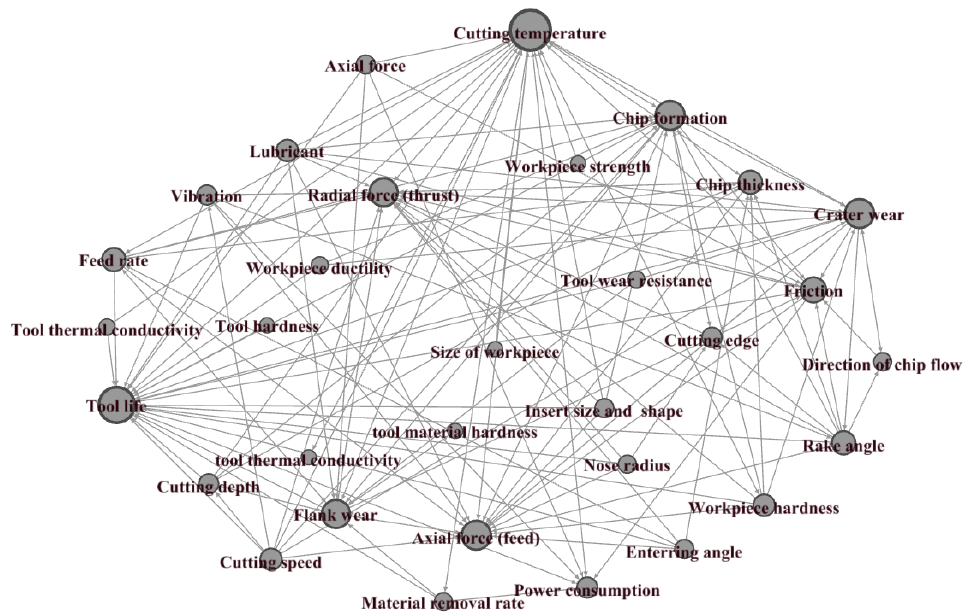
Figure 8. Graph-based analysis of parameters affecting tool life in the turning process.